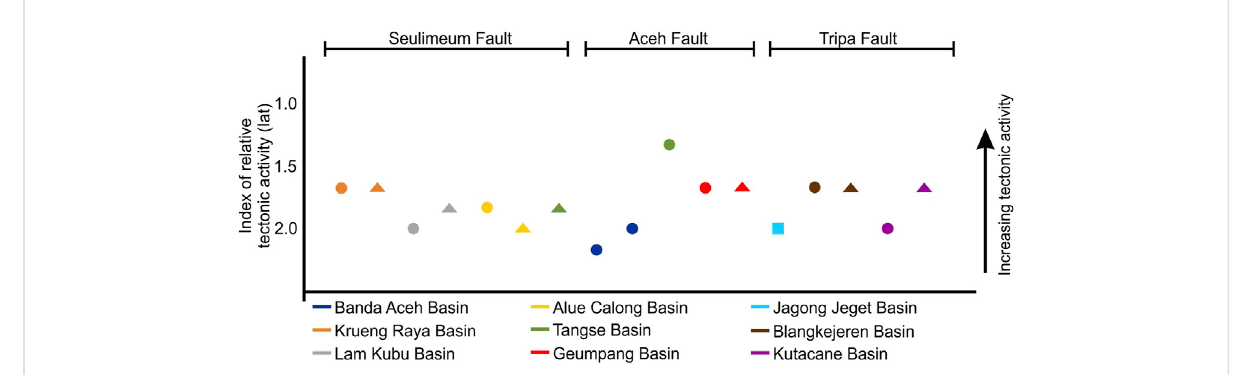
FIGURE 13 Theindexofrelativetectonicactivityofthestrike-slip basinsalongtheNorthernSumatranFault.Thetriangle,circular,andrectangleshapesare the eastern, western, and main basin-bounding faults,